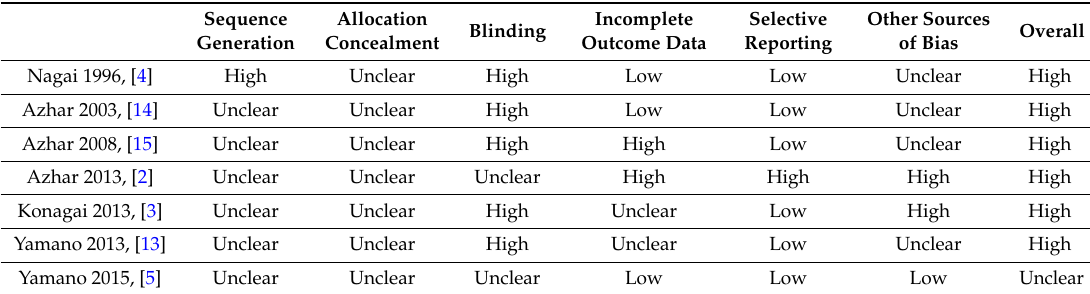
Table 3. Assessment of quality of trials using risk of bias (ROB)